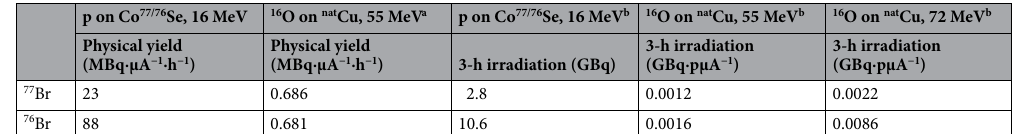
Table 3. Yield Comparison between proton and heavy-ion reactions (proton data from 5 ). a To account for indirect production, physical yields for the heavy-ion reaction are given for 4 h EOB, to allow ~ 90% of the 77 Kr to decay to 77 Br. b Since 3-h irradiations were not performed, the absolute yields are scaled from physical yield (accounting for saturation and decay effects) and reported per-particle-microamp of beam delivered (the proton data assumed a 40 μA max current for the entirety of the run). The 55 MeV data are based on data reported in this work. The 72 MeV data are a prediction from PACE calculations, since the measured data were likely depleted by krypton evaporation.